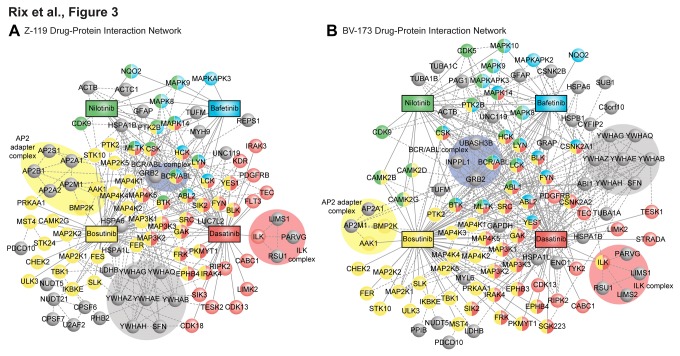
Hybrid drug-protein/protein-protein interaction networks of specific drug binding proteins.Individual cellular target profiles of nilotinib (green), dasatinib (red), bosutinib (yellow) and bafetinib (blue) were intersected with each other and overlaid with PPI data from public databases. Protein kinases and the oxidoreductase NQO2, as a validated target of nilotinib and to lesser extent of bafetinib, were considered to be direct drug binders (solid lines) and color-coded according to the drug they were interacting with. Shared kinase targets display a split color code. All other non-kinase proteins were assumed to be indirect binders (dashed lines) and displayed in grey. The analysis reveals distinct protein complexes, which are enriched by particular drugs and which are highlighted with the respectively colored background. A. Z-119 drug-protein interaction network. B. BV-173 drug-protein interaction network.